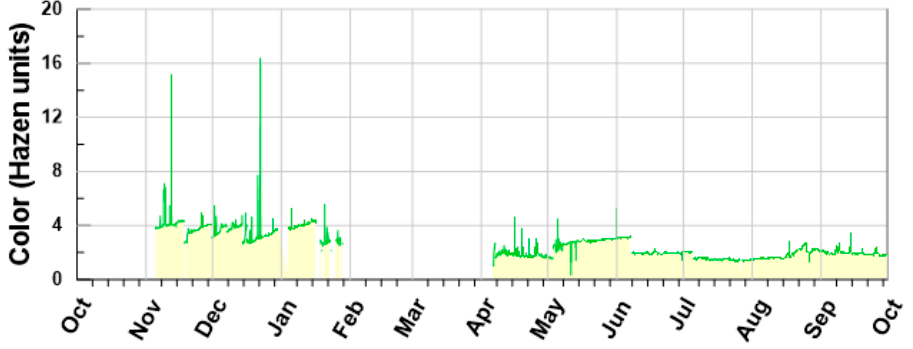
Figure 10. Time evolution of color 2020/2021.